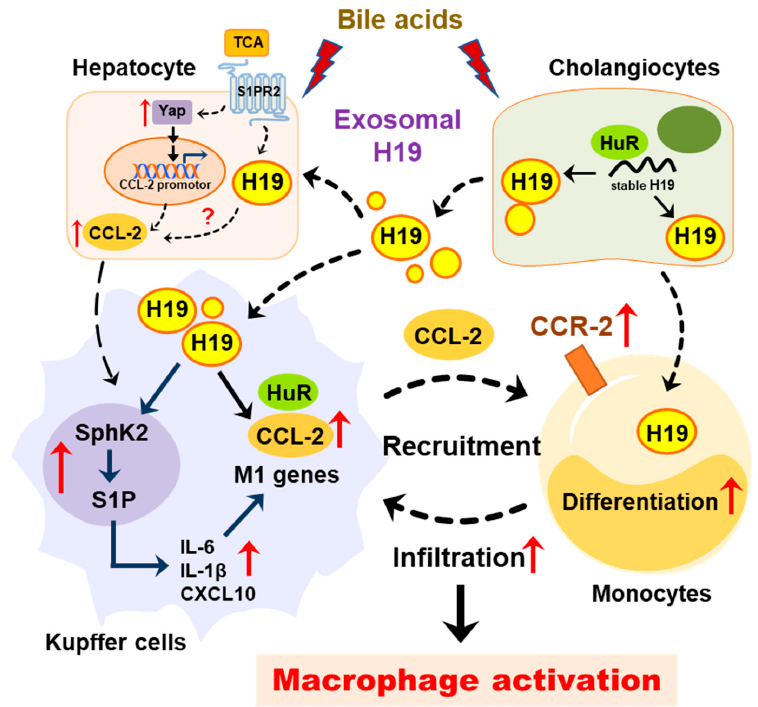
Figure 8. Schematic diagram of the proposed mechanism by which cholangiocyte-derived H19 exosomes promote hepatic inflammation and macrophage activation during cholestatic liver injury.